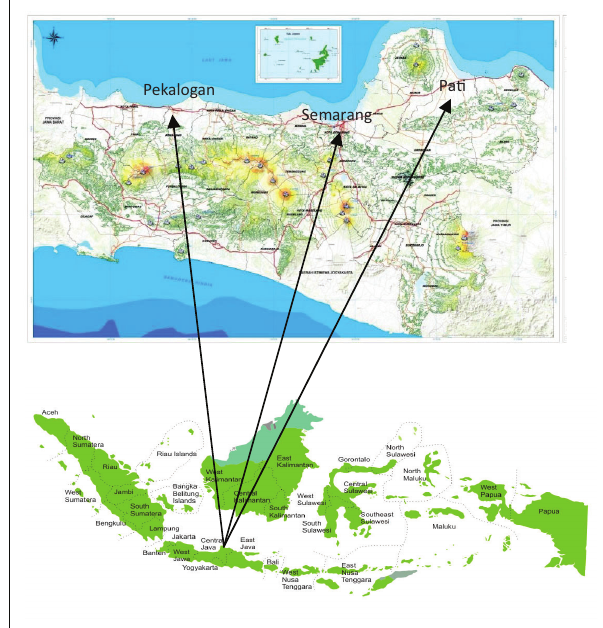
FIGURE 1: Location of the study